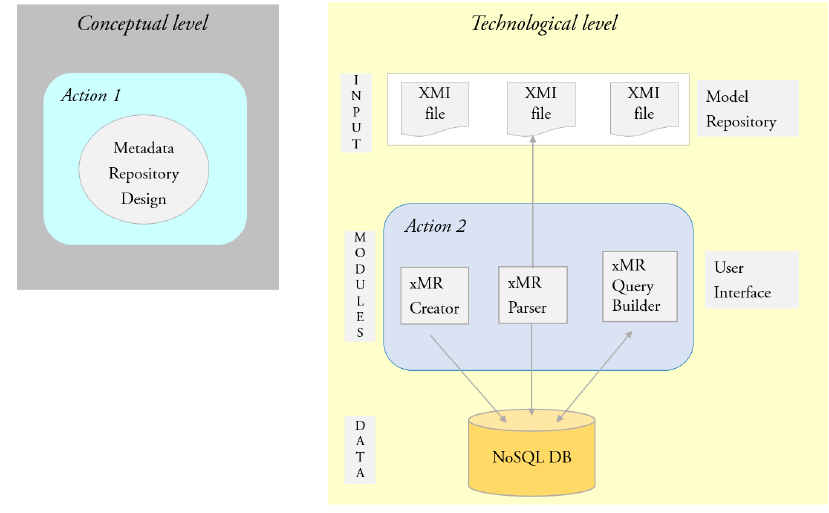
Figure 1. Overview of our approach [11].